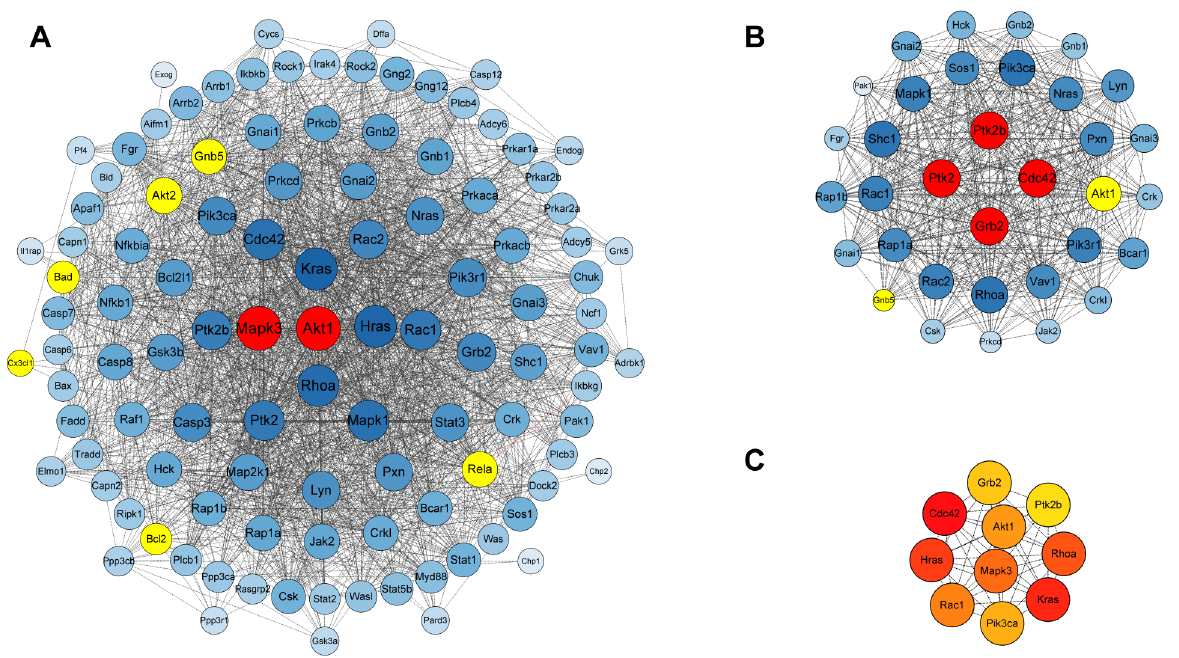
Figure 9. The PPI networks of proteins related to the chemokine signaling pathway and apoptosis. ( A ) PPI networks of all proteins from the two key pathways. ( B ) The cluster was separated by MCODE, and the score was 28.788. The size and color gradient of nodes indicate the degree of the proteins. The red core nodes represent the highest degree. The proteins verified by Western blot analysis are highlighted in yellow. ( C ) The network was obtained with the top 10 Hubba nodes ranked by MCC using cytoHubba. The darker the red color, the more vital the proteins.